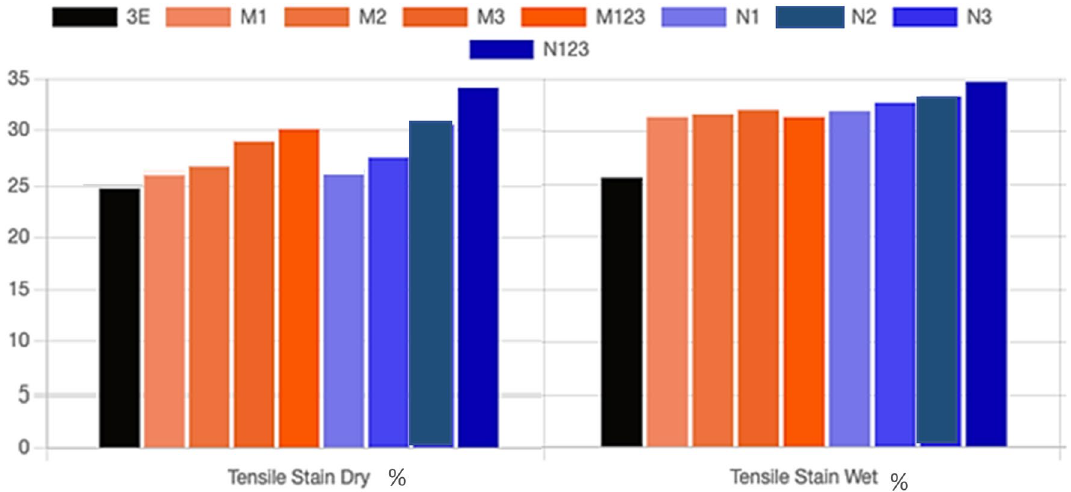
Figure 7. Tensile strain of micro/nanocomposite coating under dry and wet